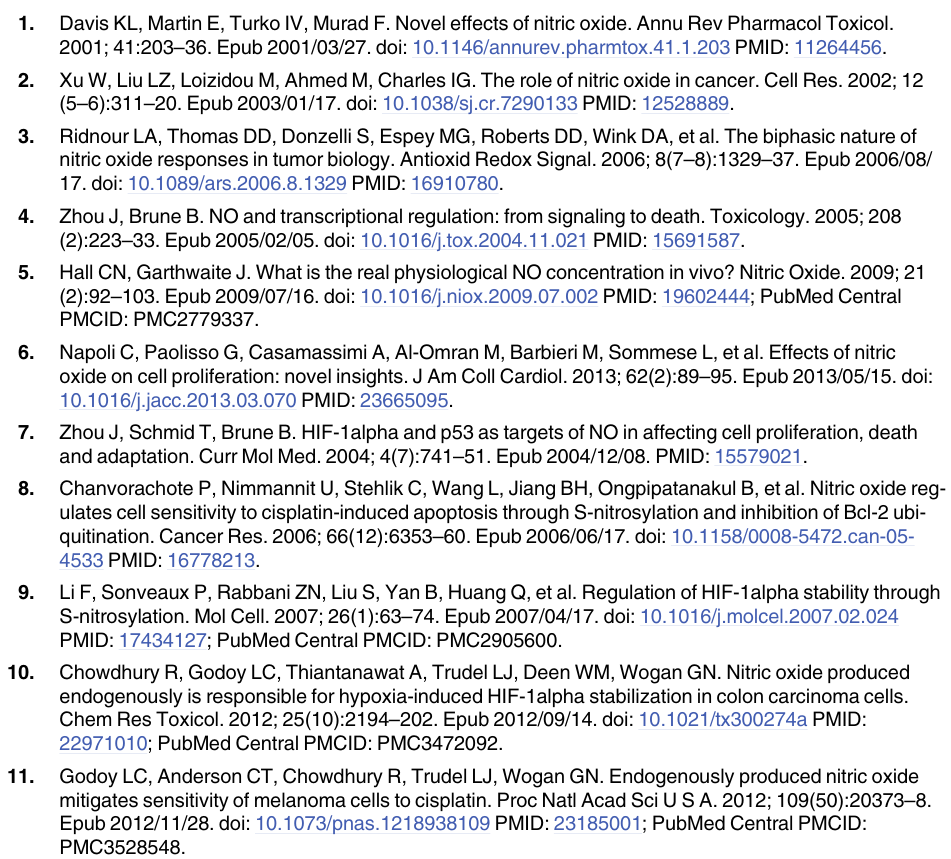
S2 Fig. Representative confocal microscopy for topo I nitrosation in HT-29 and MCF-7 cells following treatment with 100 μ M PPNO. (PDF) S3 Fig. Apoptotic Analysis for HT-29 and MCF-7